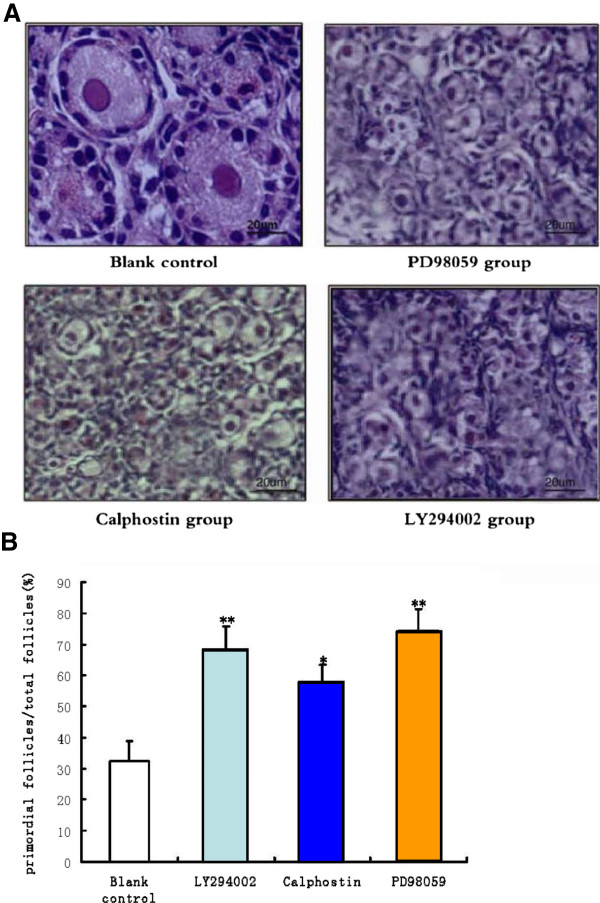
Effect of PD98059, Calphostin and LY294002 on the activation of primordial follicle growth.A, Ovaries were cultured for 8 days with treatments: blank control, PD98059(5 × 10-2 mmol/L), Calphostin (5 × 10-4 mmol/L)and LY294002(5 × 10-2 mmol/L). Ovarian sections were stained with hematoxylin and eosin to show the follicles at different developmental stages. Scale bar: 20 μm. HE staining X400 B, The number of follicles was counted in serial cross-sections. ** P<0.01 vs. blank control.